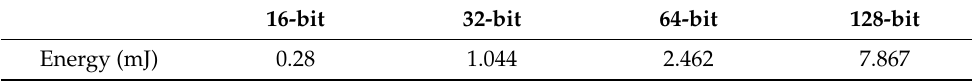
Table 3. Energy consumption of different precision